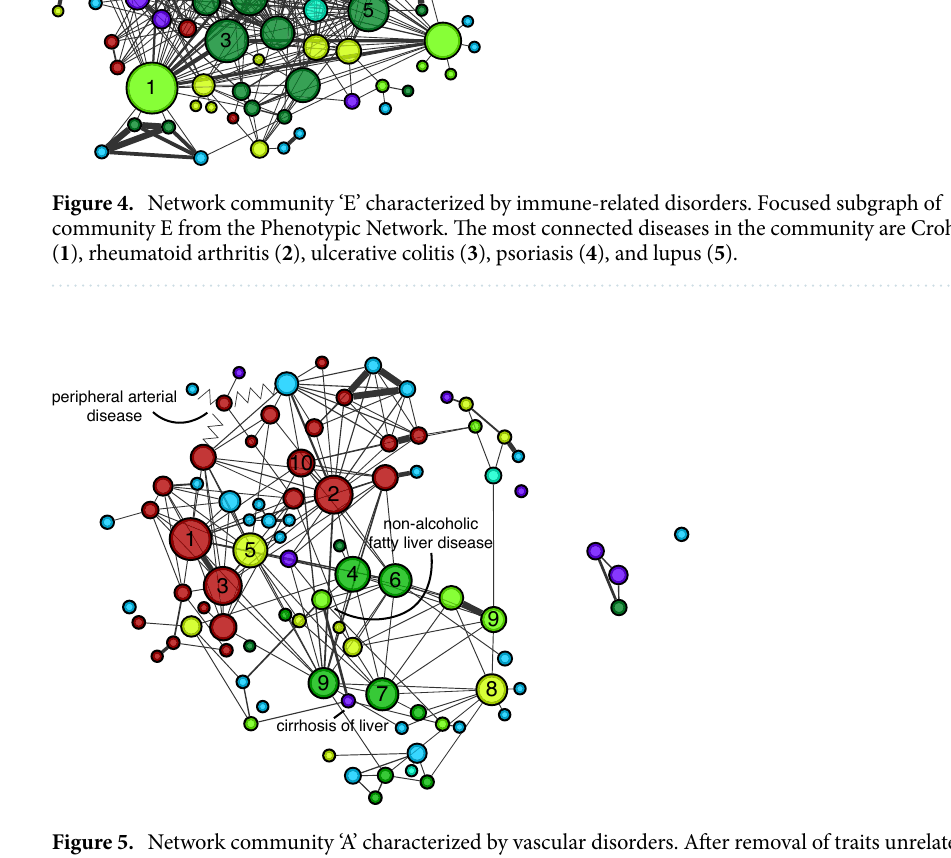
Figure 5. Network community ‘A’ characterized by vascular disorders. After removal of traits unrelated to diseases from the visualization, the most connected nodes in the community were coronary heart disease ( 1 ), stroke ( 2 ), coronary artery disease ( 3 ), metabolic syndrome ( 4 ), cardiovascular disease ( 5 ), hypertriglyceridemia ( 6 ), gout ( 7 ), chronic kidney disease ( 8 ), diabetes mellitus ( 9 ), and atrial fibrillation ( 10